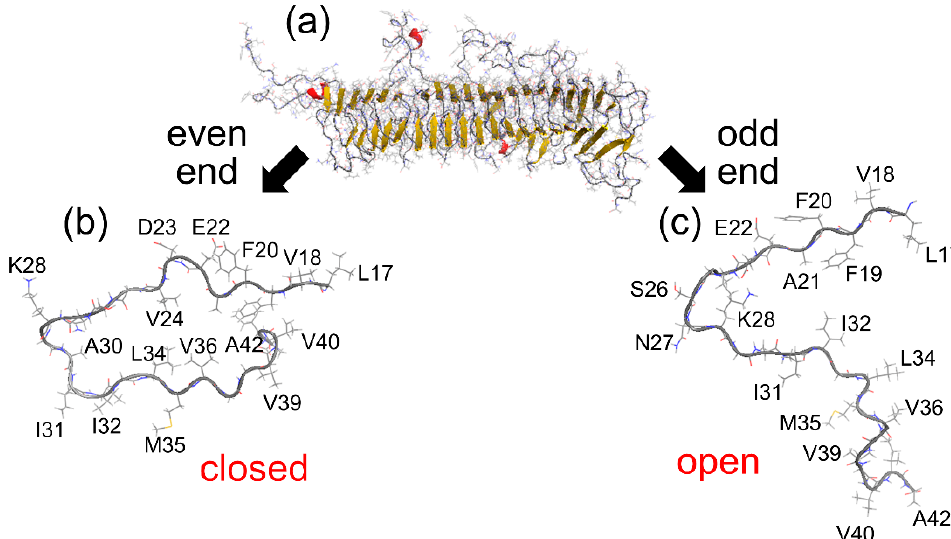
Figure 11. ( a ) A snapshot of the A β amyloid fibril. ( b ) Side view of the A β peptide at the even end. ( c ) Side view of the A β peptide at the odd end. The figures were created using PyMOL [171]. Re- printed with permission from Ref. [72]. Copyright 2016 Springer